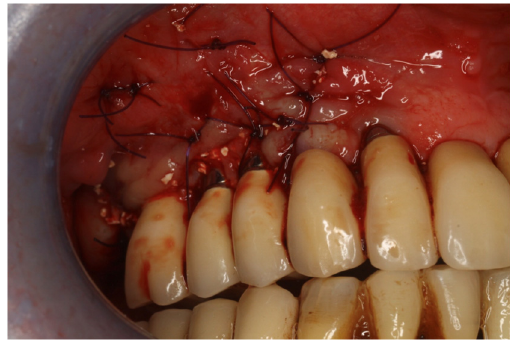
Figure 6. OHLLT surgical approach. Flap repositioning and suture.